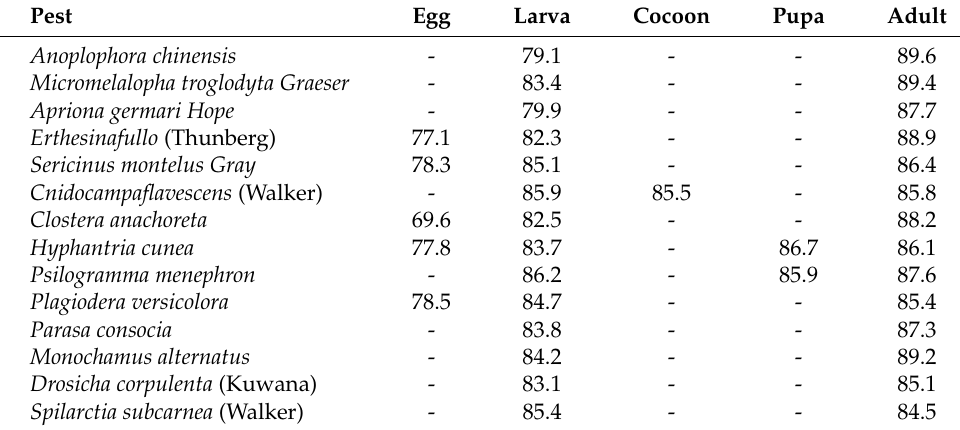
Table 6. mAP of each subclass in pest